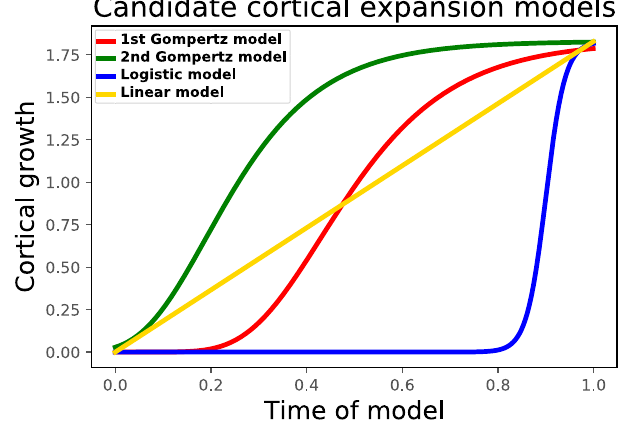
Figure 1. Curves of the cortical growth defined by different expansion